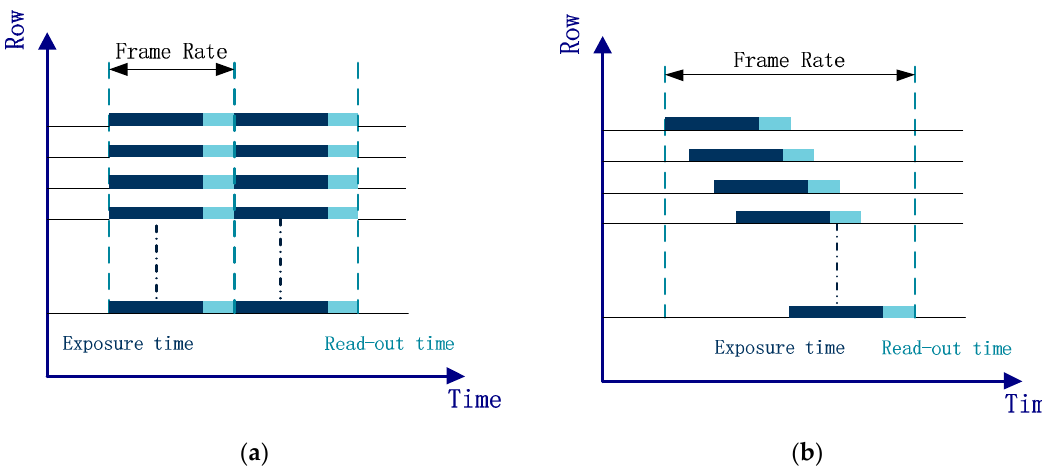
Figure 1. Schematic diagrams of the: ( a ) global shutter of the CCD sensor; and ( b ) rolling shutter of the CMOS sensor.